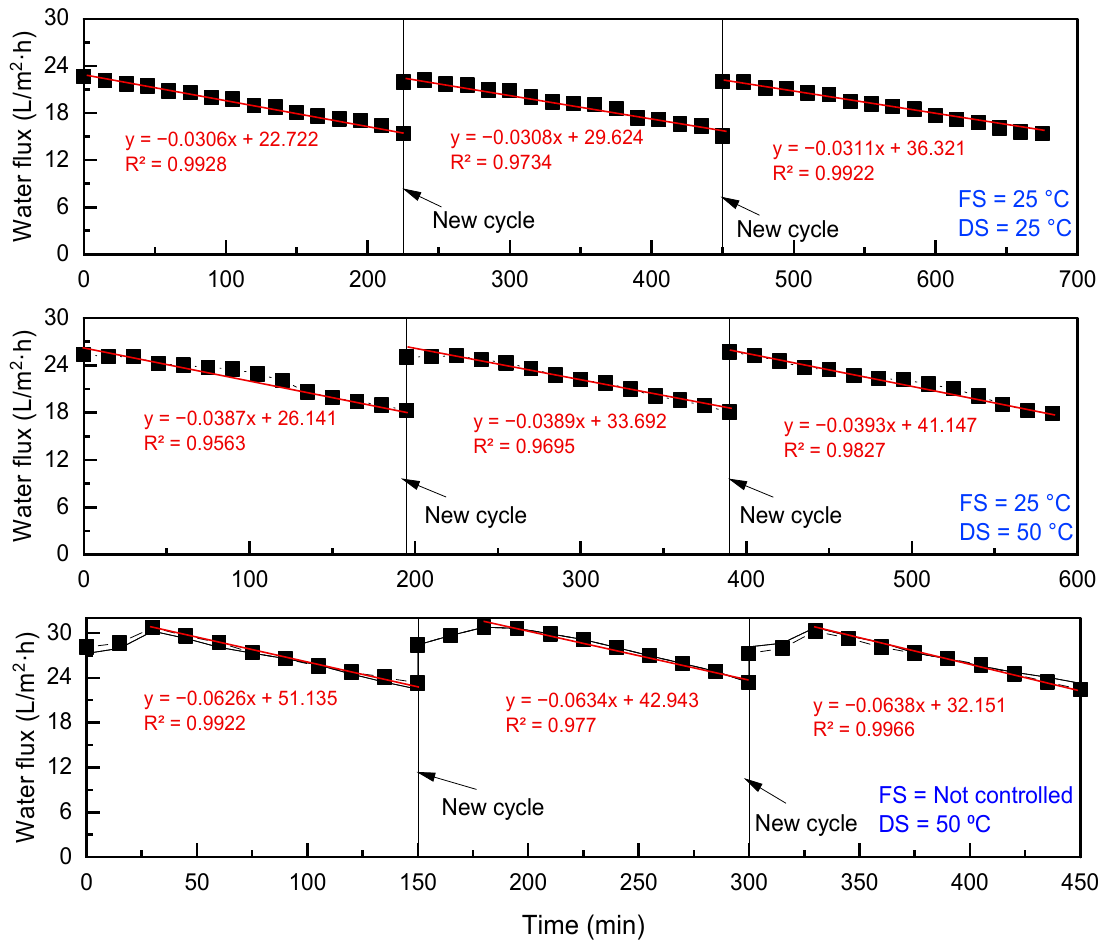
Figure 5. The decline in water flux in three consecutive cycles of FO membrane filtration with a 70% water recovery rate when treating synthetic municipal wastewater at different FS and DS tempera- tures.